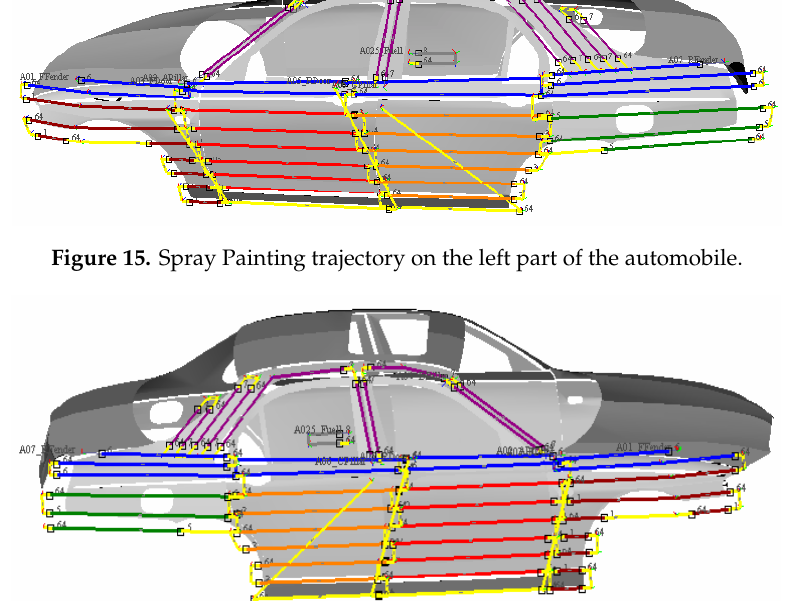
Figure 16. Spray Painting trajectory on the right part of the automobile.